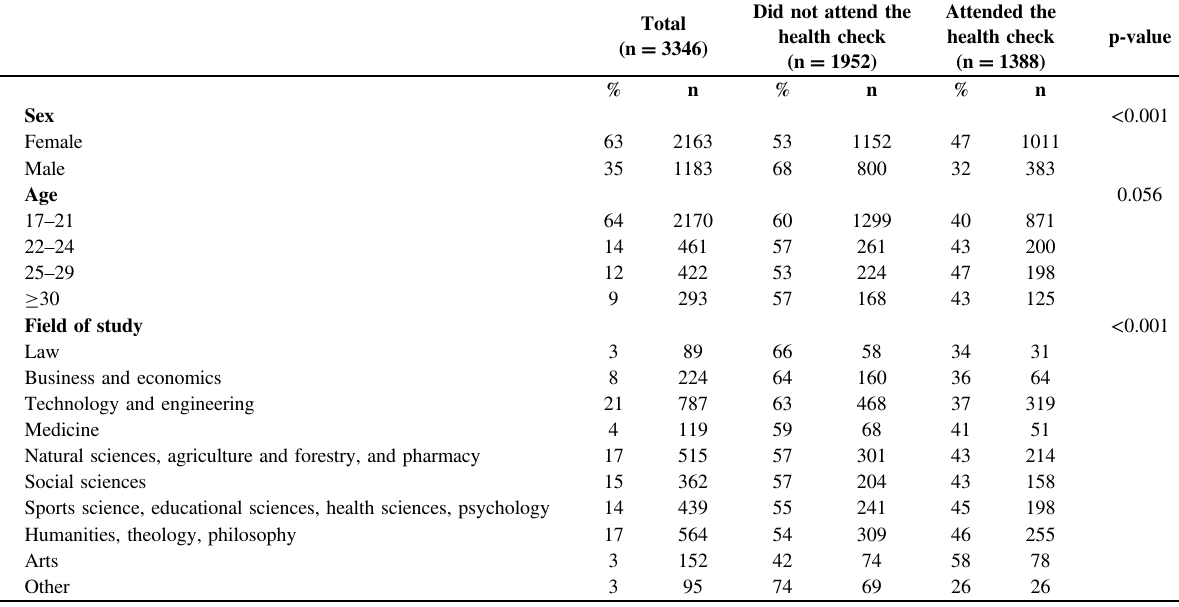
P-values result from the Chi-square tests and describe di ff erences in sex, age and fi eld of study between students who attended and did not attend the health check.